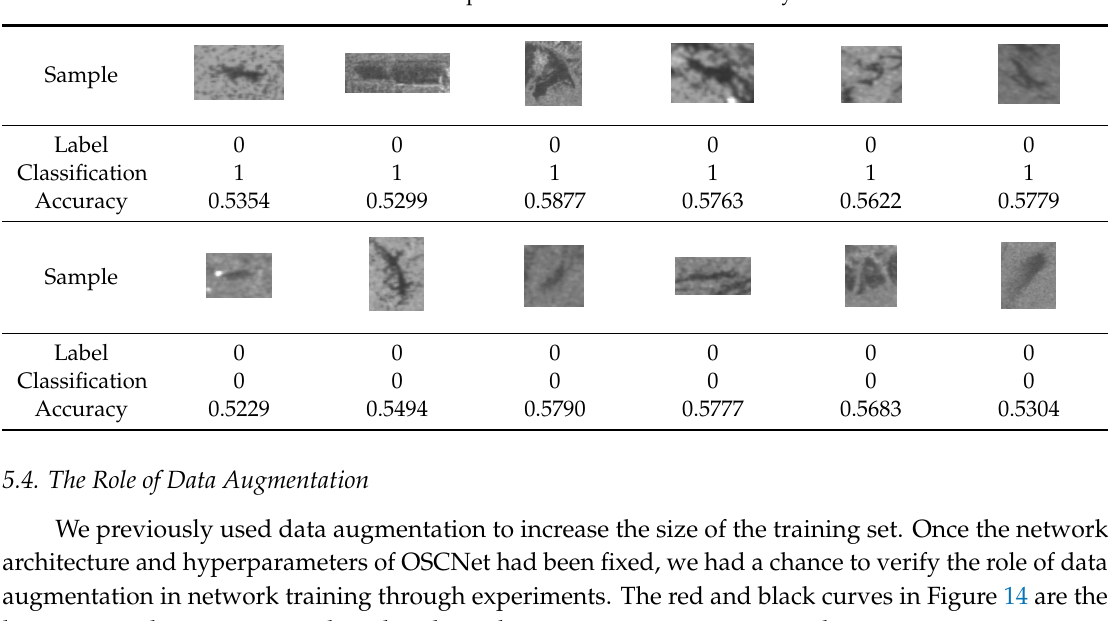
Table 13. Examples of lookalikes hard to classify.